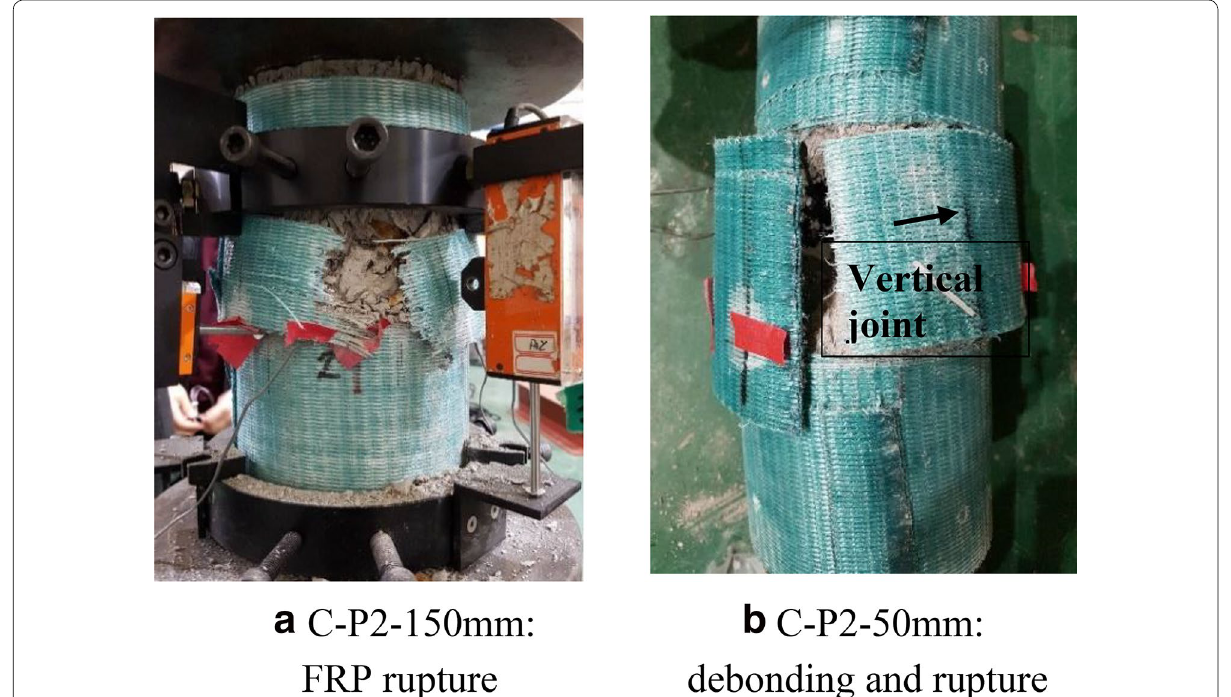
Fig. 16 Failure mode of PEN FRP-confined cylinders: additional confinement